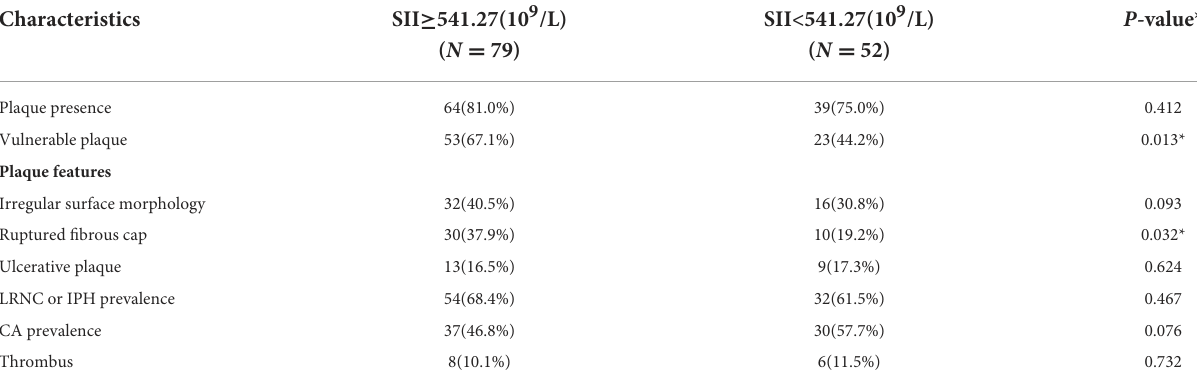
TABLE 2 CDU imaging findings of carotid responsible plaques in patients with different SII levels.